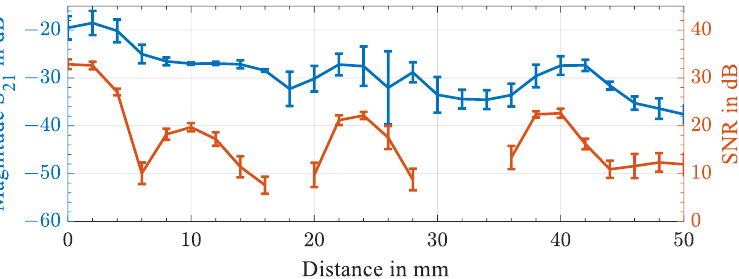
Figure 10. Minimum insertion loss S 21 of the piezoelectric transducers T R and T S in blue and the signal-to-noise ratio of a wirelessly read out resonance frequency at room temperature in orange through a 15 mm thick CFRP plate with the axial displacement of the transducers ranging from 0 to 50 mm.